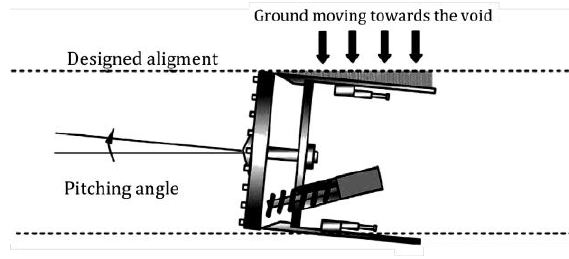
Figure 4. Ground movement caused by pitching angle [15].